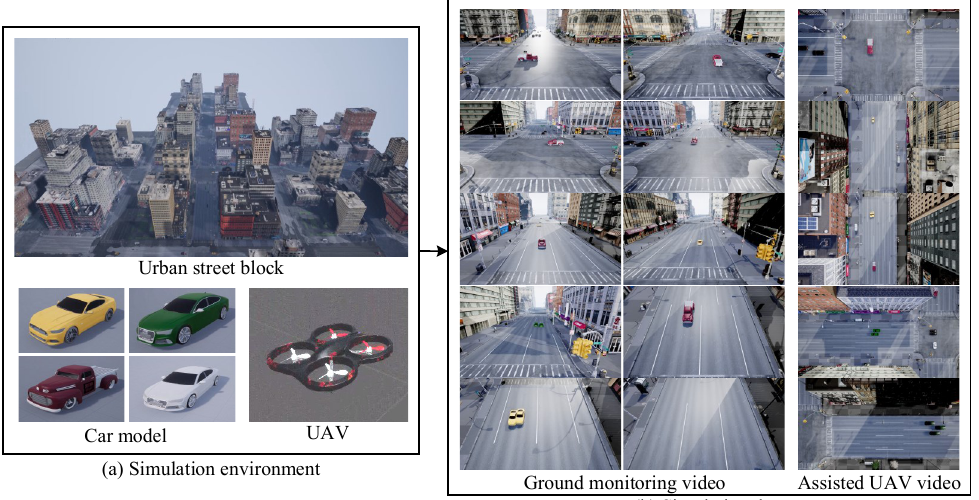
Figure 7. Our simulation database . ( a ) Simulation environment. The top left figure is a model of urban street block. The car models and UAV used in database are displayed below. ( b ) Some examples of ground monitoring videos and assisted UAV videos in this simulation database.